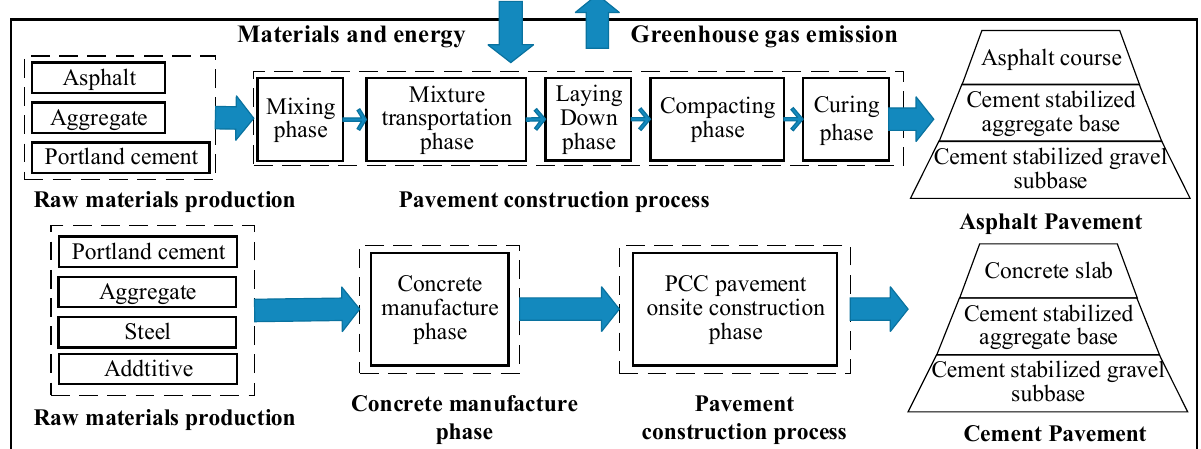
Figure 1. System boundary of this study.